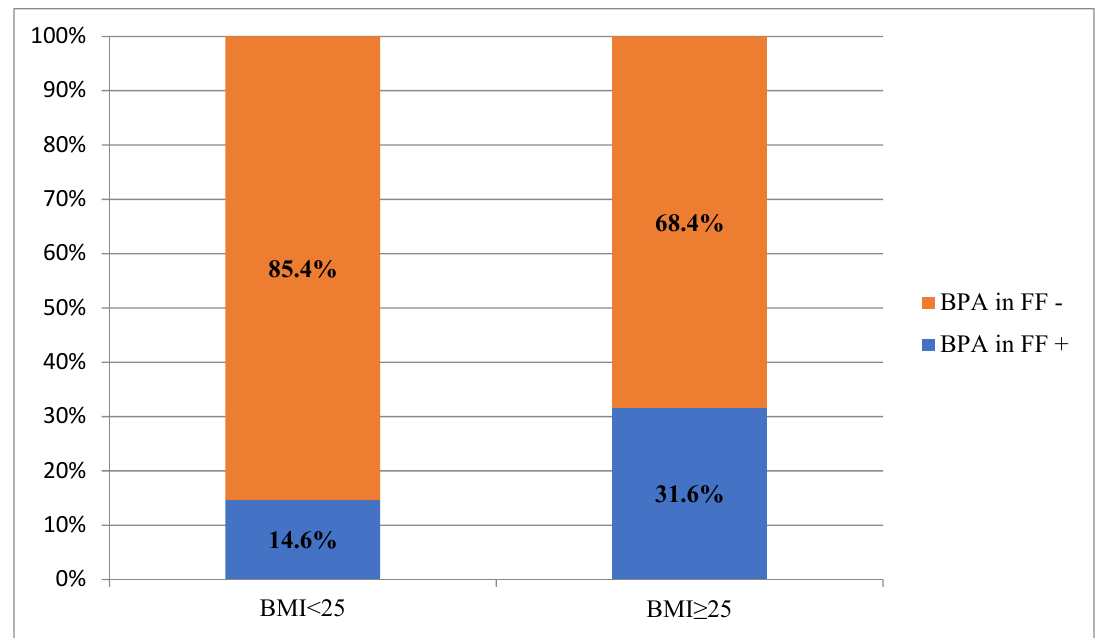
Figure 2. The presence of BPA in FF in accordance to female BMI.